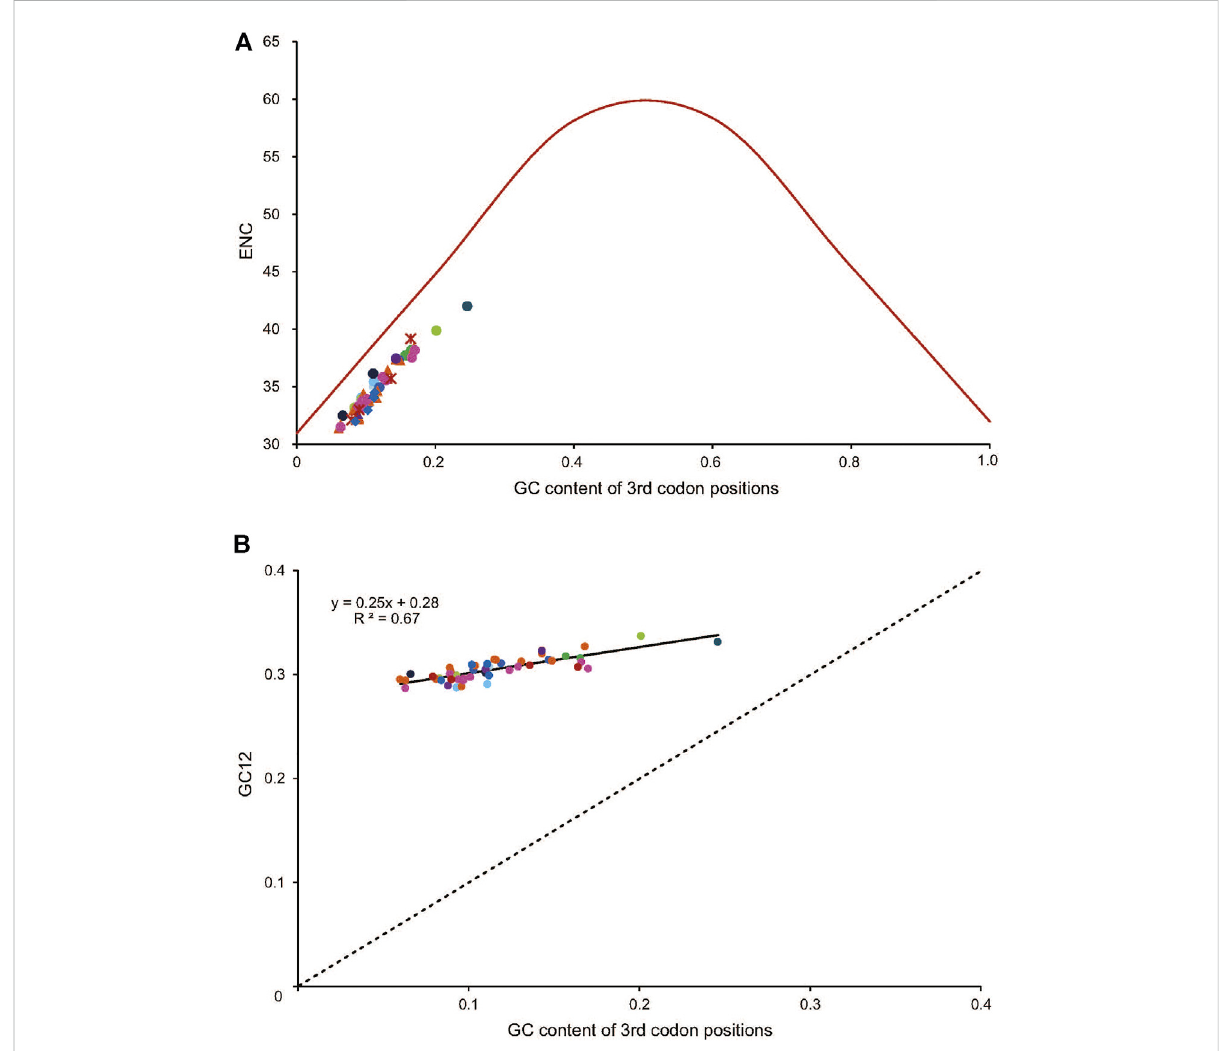
FIGURE 5 The correlation between the effective number of codons (ENC) and G + C content of the third codon positions (GC3) for 50 spider species of the retrolateral tibial apophysis clade. The colored dots match those in Figure 2. (A) The solid line represents the relationship between the ENC* (2